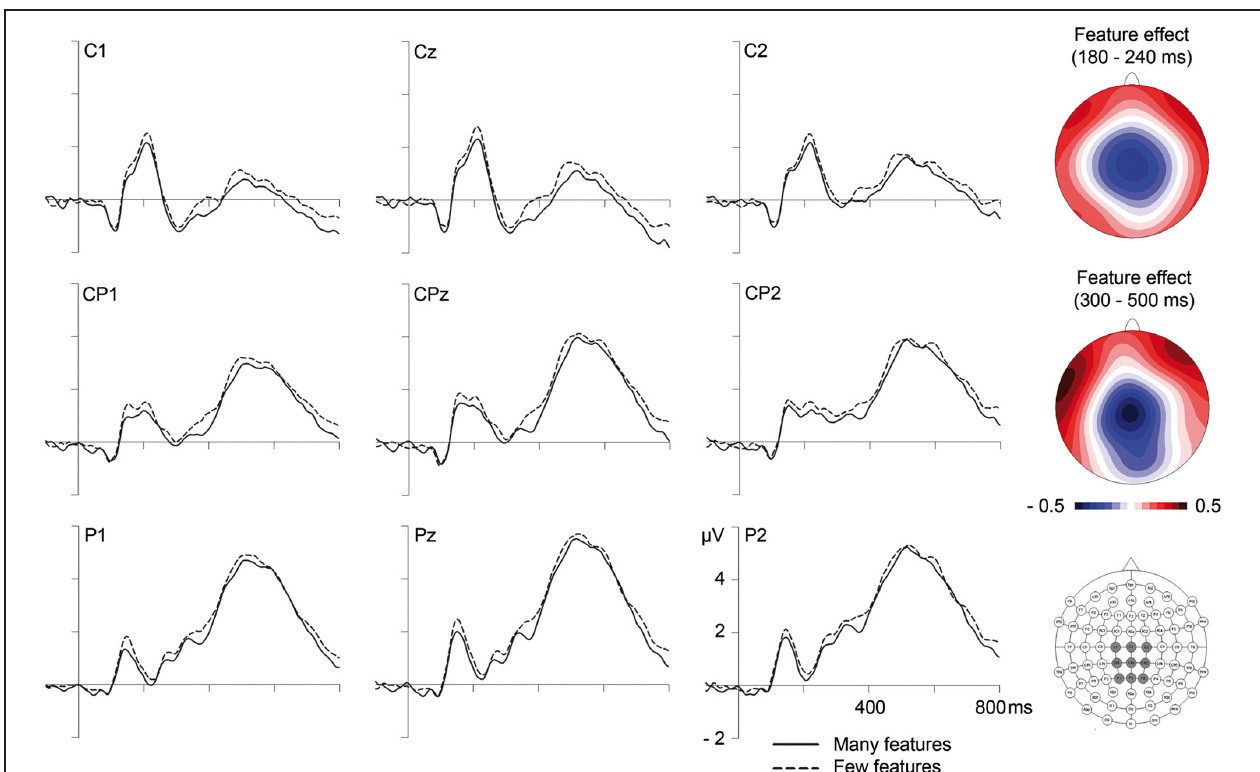
FIGURE 3 | Influences of the number of semantic features on event-related brain potentials at centro-parietal electrode sites. On the right are topographical distributions of feature effects (many minus few